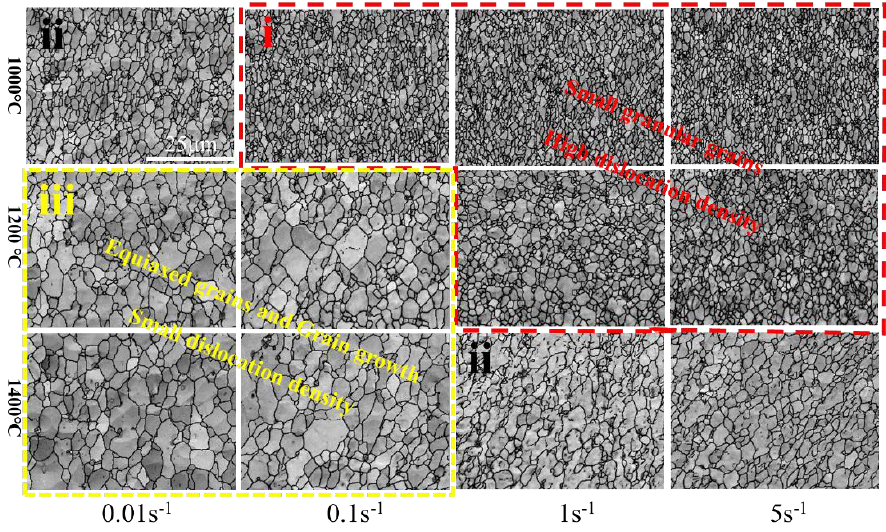
Figure 24. Microstructure development of Mo − 1.5wt%ZrO2 alloy under different deformation